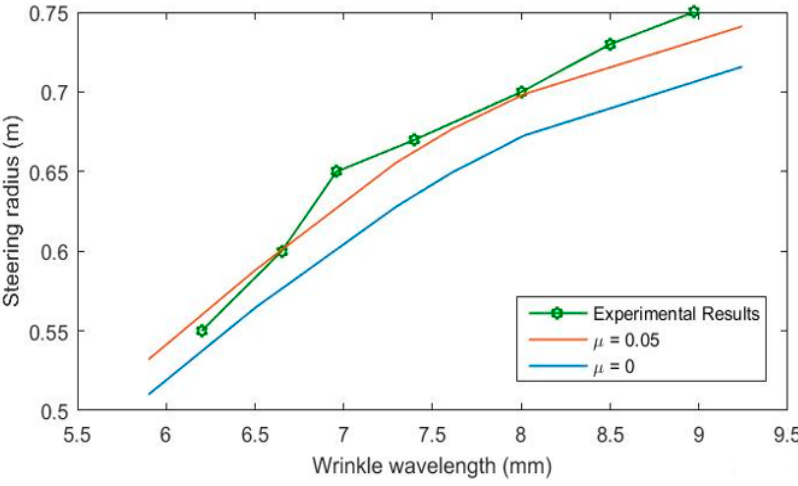
Figure 13. Wrinkle wavelength of the tape versus different steering radius.